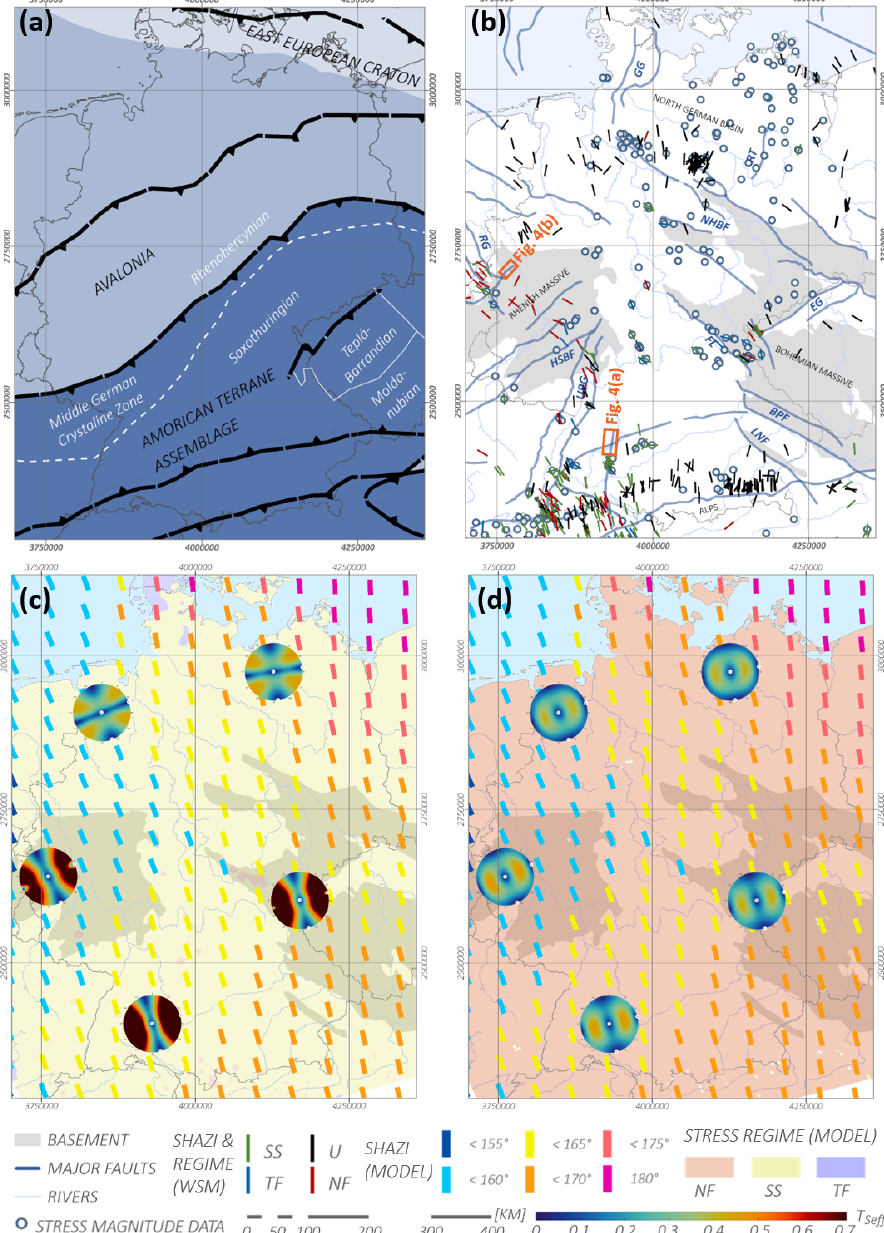
Figure 1. (a) Crustal units in Germany are indicated by different shades of blue and labeled with dark gray, capital text. White text labels Variscan units. Modified after Meschede and Warr (2019) and Ahlers et al. (2021a). (b) Stress data available in Germany: the rotated line markers represent data on the orientation of the maximum horizontal stress ( S Hazi ) available in the World Stress Map (Heidbach et al., 2016) and are colored by the stress regime associated with the data points (normal faulting (NF), strike-slip faulting (SS), thrust faulting (TF) and unknown regime (U)). Plotted alongside are the locations of stress magnitude data (Morawietz and Reiter, 2020) and major tectonic faults in Germany as blue lines with (outcropping) basement structures indicated by gray areas The location of Fig. 4a and b is indicated by orange squares. BPF: Bavarian Pfahl Fault; EG: Eger Graben; FL: Franconian Line; GG: Glückstadt Graben; HSBF: Hunsrück Southern Border Fault; LNF: Landshut–Neuötting Fault; NHBF: Northern Harz Boundary fault; RG: Roer Valley Graben: RT: Rheinsberg Trough; URG: Upper Rhine Graben (modified after Kley and Voigt, 2008 and Ahlers et al., 2021a). Panels (c) and (d) : the stress regime calculated by the Germany model at 1 and 8km depth, respectively, is indicated by the background color; S Hazi calculated by the Germany model has been averaged along a regular grid. The mean S Hazi of each grid point is indicated by the orientation and color of the marker. For five areas within the model area, fault reactivation stereo plots are shown, displaying what fault orientations and dips are most favorable for reactivation under the given stress conditions. ©EuroGeographics for the administrative